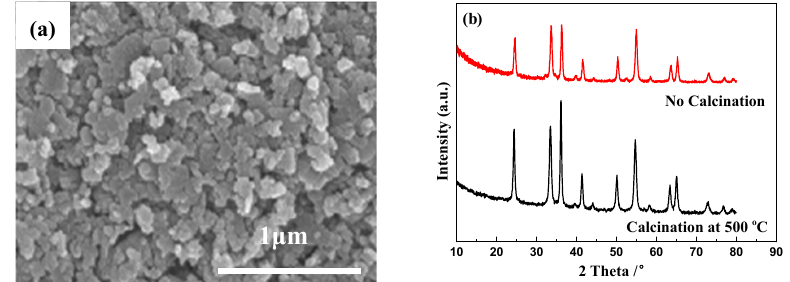
Figure 7. SEM image of Cr 2 O 3 -SCS following calcination at 500 °C for 2 h ( a ) and XRD patterns of Cr 2 O 3 -SCS before and after calcination at 500 °C for 2 h ( b ).